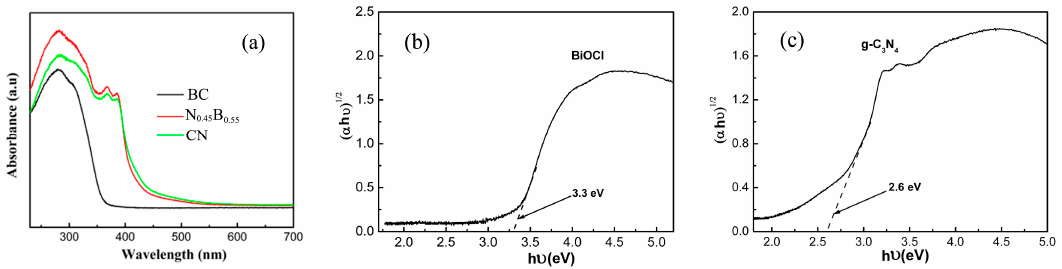
Figure 6. ( a ) UV-vis diffuse reflectance spectra of BiOCl, g-C 3 N 4 , and N 0.45 B 0.55 samples; ( b ) the corresponding ( α h ν ) 1/2 vs. photon energy (h ν ) plot of BiOCl sample; and ( c ) the corresponding ( α h ν ) 2 vs. photon energy (h ν ) plot of bare g-C 3 N 4 sample.